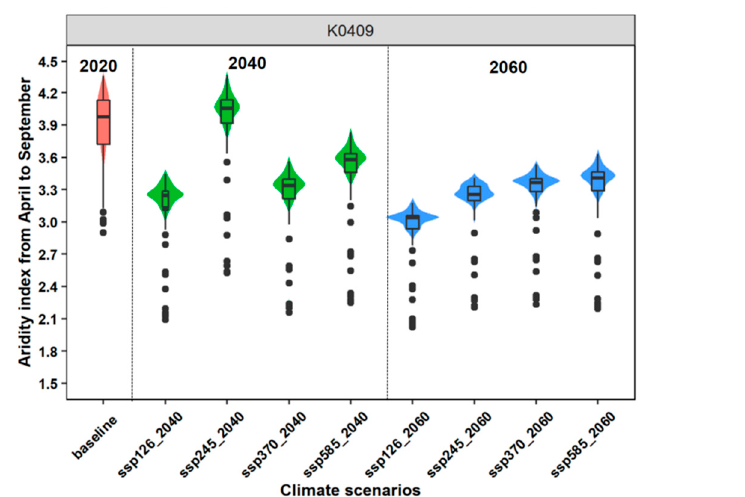
Figure 8. P09, P0709, and K0409 in Ningxia under current (2001–2020) and future (SSP126, SSP245, SSP370, and SSP585 for the periods of 2021–2060) climates. Note: P09, P0709, and K0409 represent total precipitation in September, total precipitation from July to September, and aridity index from April to September.